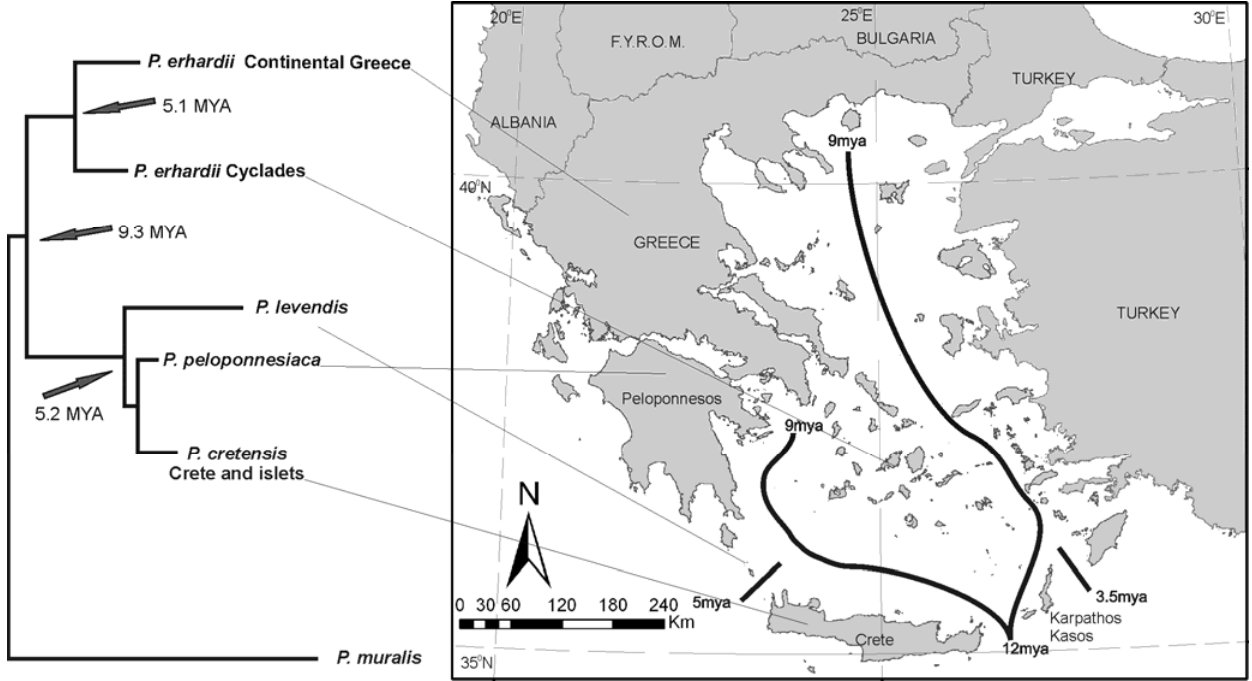
Figure 4. Phylogenetic relationships of P. erhardii group. Note that the taxa respect the 12-9 MYA boundaries and that contemporary species differentiate around 5 MYA, i.e. , near the Messinian crisis.